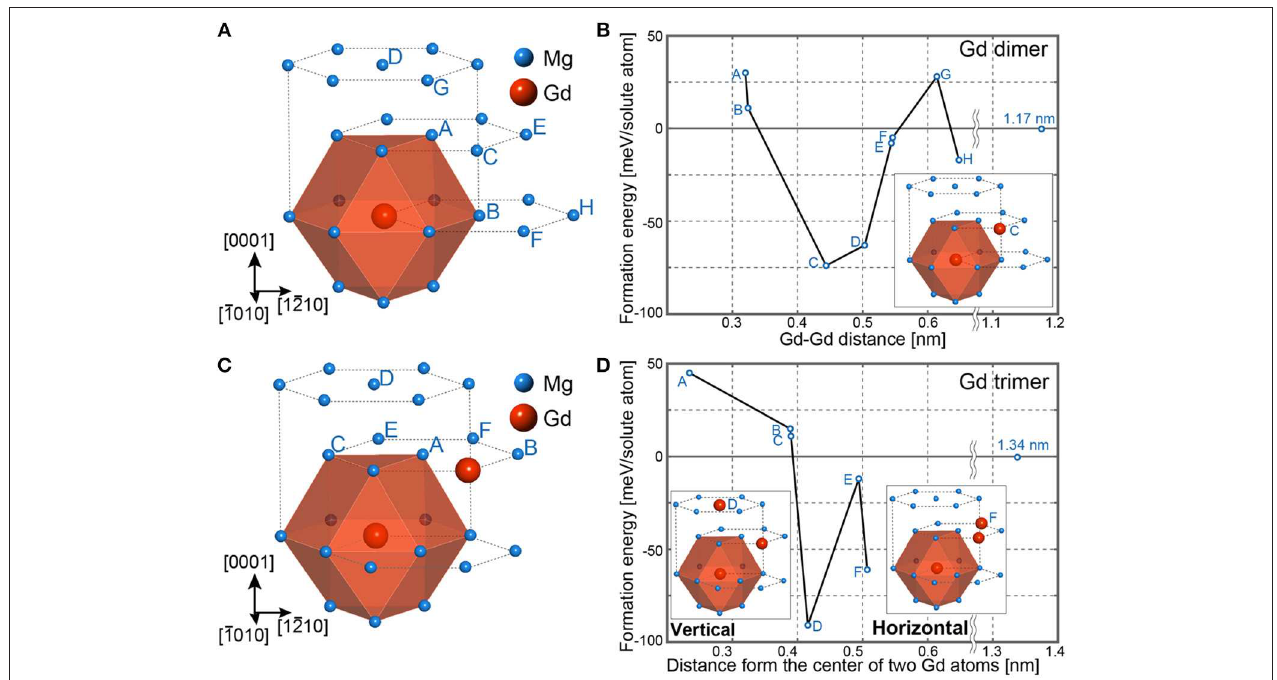
FIGURE 4 | First-principles calculations of the Gd (A,B) dimer and (C,D) trimer embedded in the hcp -Mg structure. Calculations were made with a hcp -base 5 × 5 × 4 supercell containing 200 atoms. Atom positions used for the second and the third Gd atoms are denoted by capital letters in (A,C) , respectively. Calculated formation energies of the Gd (B) dimer and (D) trimer at the each position in (A,C) , respectively. For the both cases, representative energy-minimized Gd configurations are inserted. For computations, the cut-off energy is chosen as 350eV, with a 3 × 3 × 3 k-mesh. Calculations are performed by non-fixed conditions both for atomic positions and a unit-cell